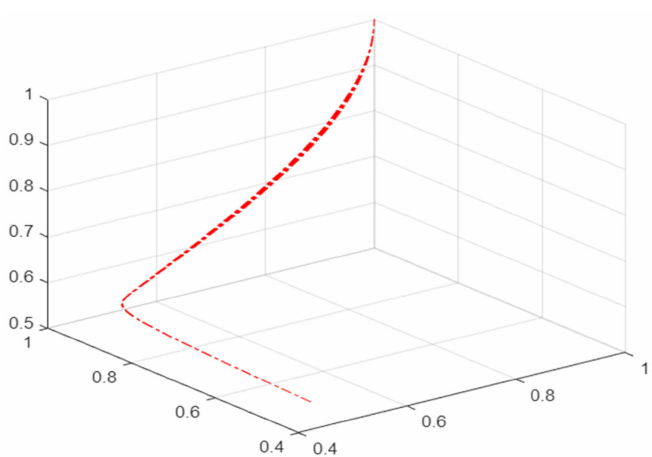
Figure 7. Sensitivity analysis of parameter U.